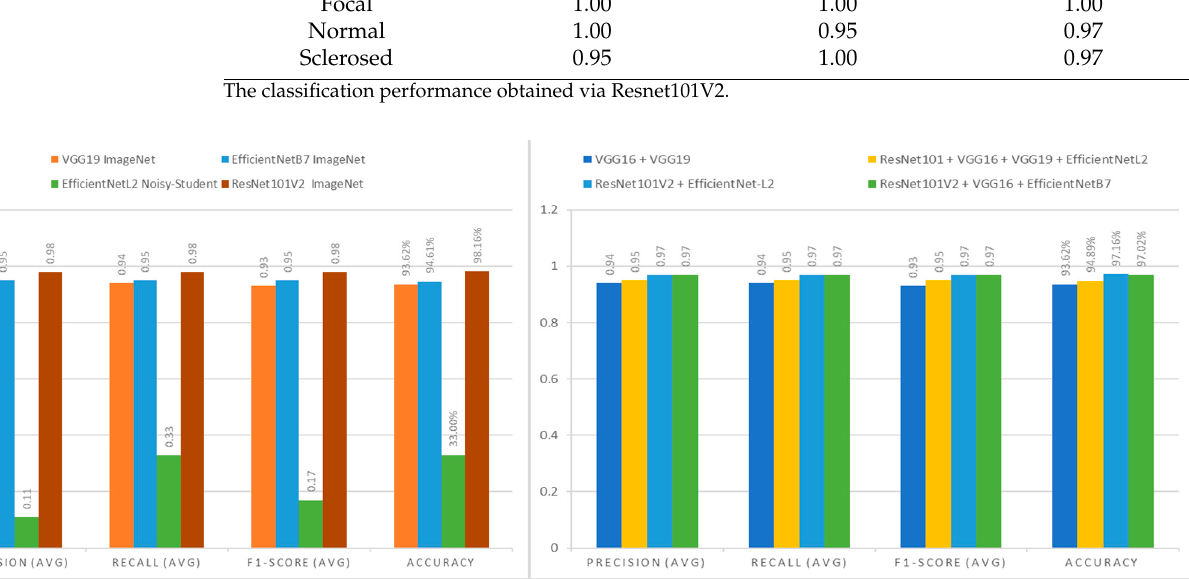
Figure 8. Comparison performance evaluation metrics. ( Left ) Comparison performance independent model and ( Right ) comparison performance combination model. The average of each of the evaluation metrics is obtained from the total evaluation metrics value per epoch divided by the total epoch from each model .